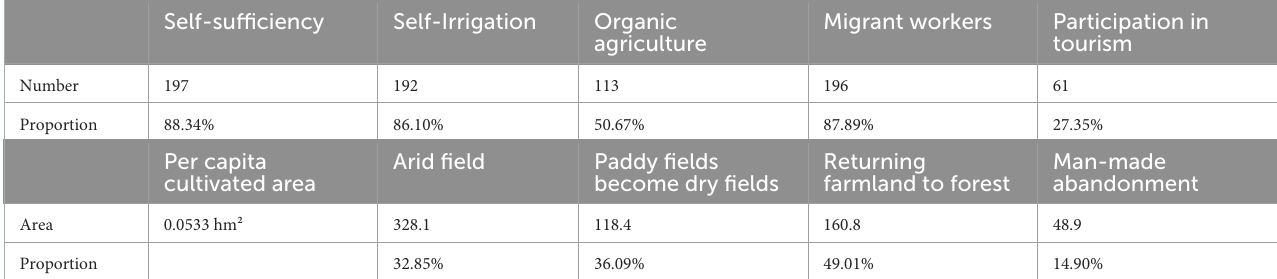
TABLE 2 Descriptive statistics of the survey